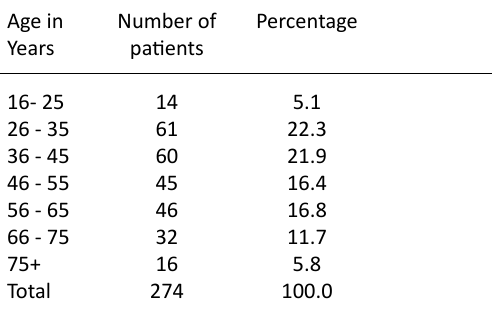
Table 1. Distribution of age groups